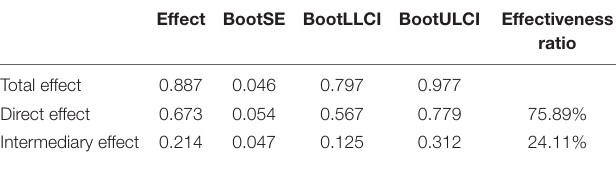
TABLE 8 | Decomposition of the total effect, direct effect, and mediating